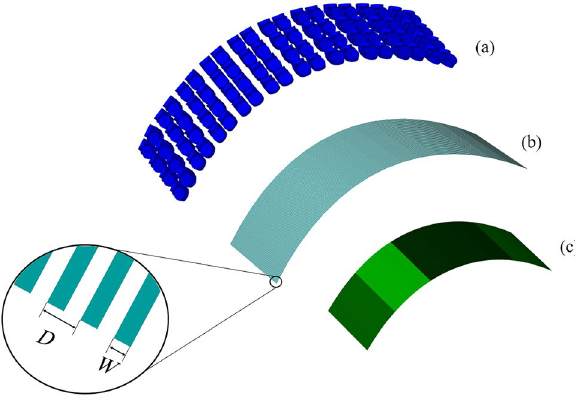
Figure 11. Proposed 3-layer hybrid